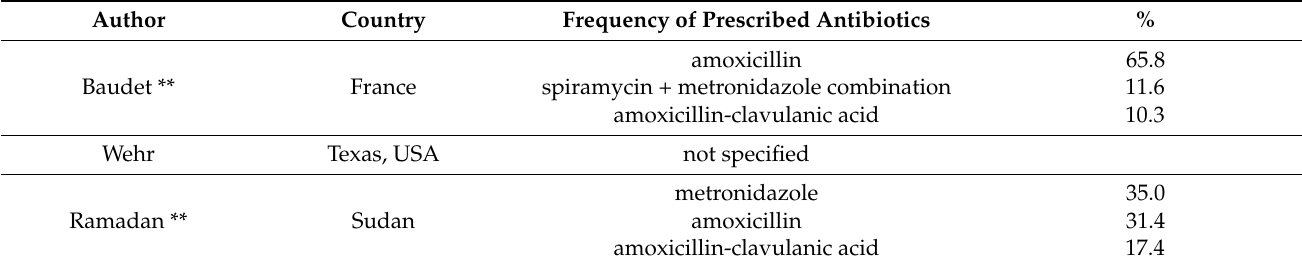
Table 8. Frequency of prescribed